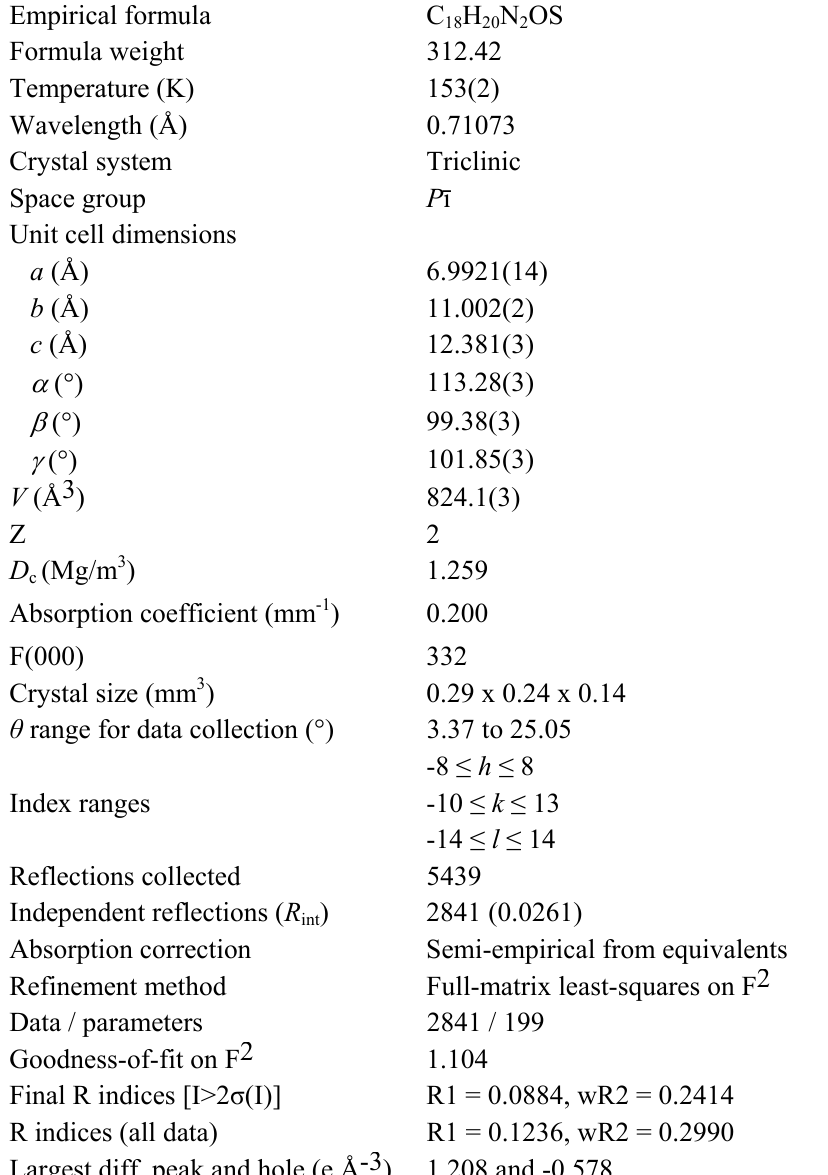
Table 1. Summary of crystallographic data and parameters of N -(naphthalen-1-